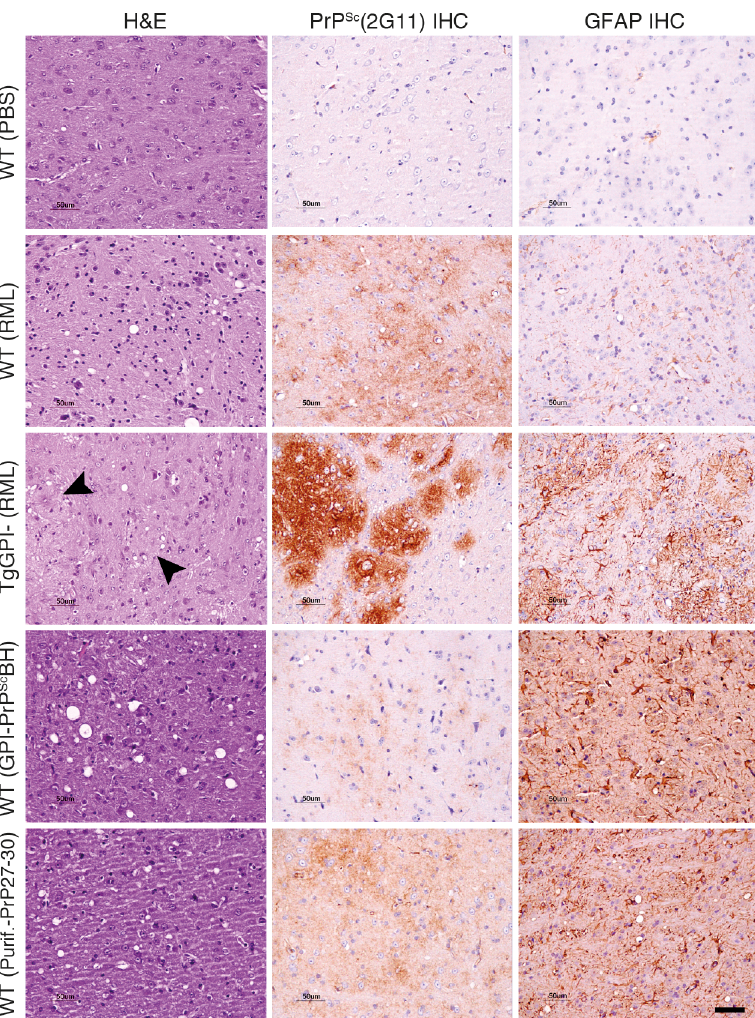
Fig 2. Histopathological and immunohistochemical analyses. Brain tissue sections of the thalamus: one section was stained with hematoxylin and eosin (H&E, left), two others were analyzed via immunohistochemistry (IHC) using the anti-PrP antibody 2G11 (middle) and an antibody against the glial fibrillary acidic protein (GFAP) to reveal astroglial activation (right). Control WT mice inoculated with PBS (first row); WT mice infected with RML prions (second row); and transgenic mice expressing GPI-anchorless PrP infected with RML prions (third row). Black arrowheads indicate the presence of hyaline deposits, which stain PrP angiocentric plaques. WT mice infected with GPI-anchorless PrP Sc BH (fourth row); and WT mice infected with purified GPI-anchorless PrP 27 – 30 (fifth